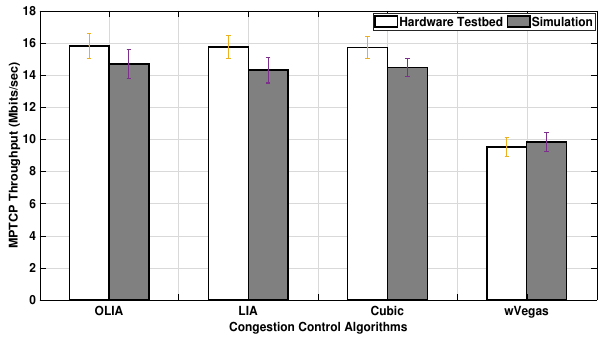
Figure 10. Setup 2 Downlink MPTCP